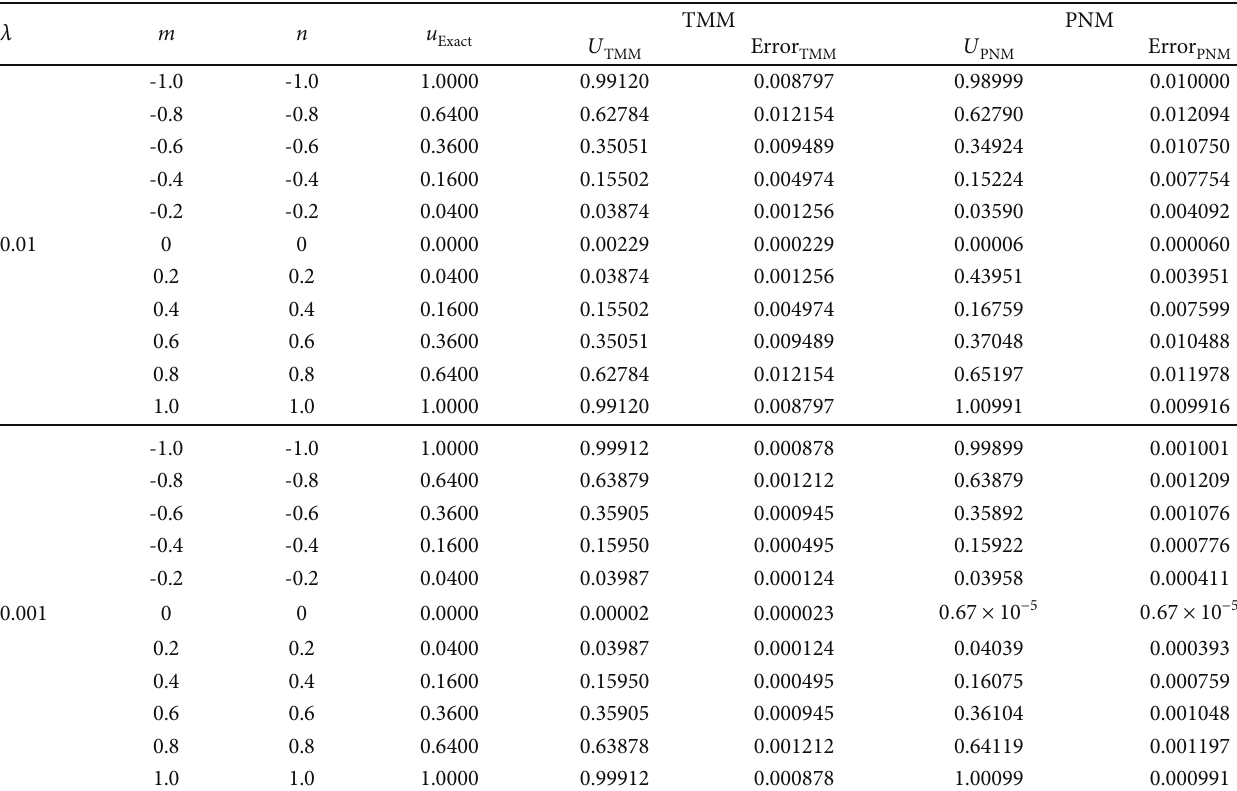
Table 1: Numerical values and absolute error values by using TMM and PNM, n = 20 , at linear case k = 1 . λ m n u